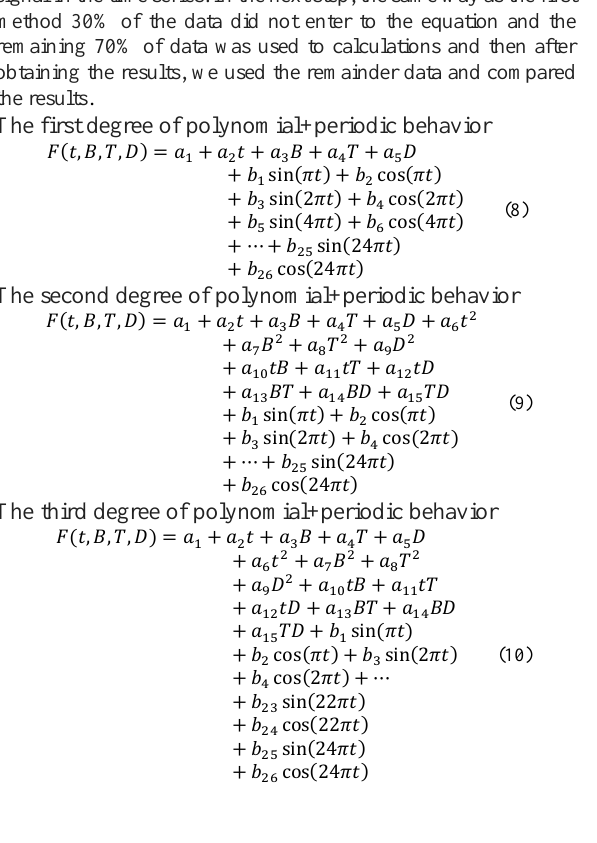
Figure 14: The regression graph of 2 nd degree polynomial + periodic behavior